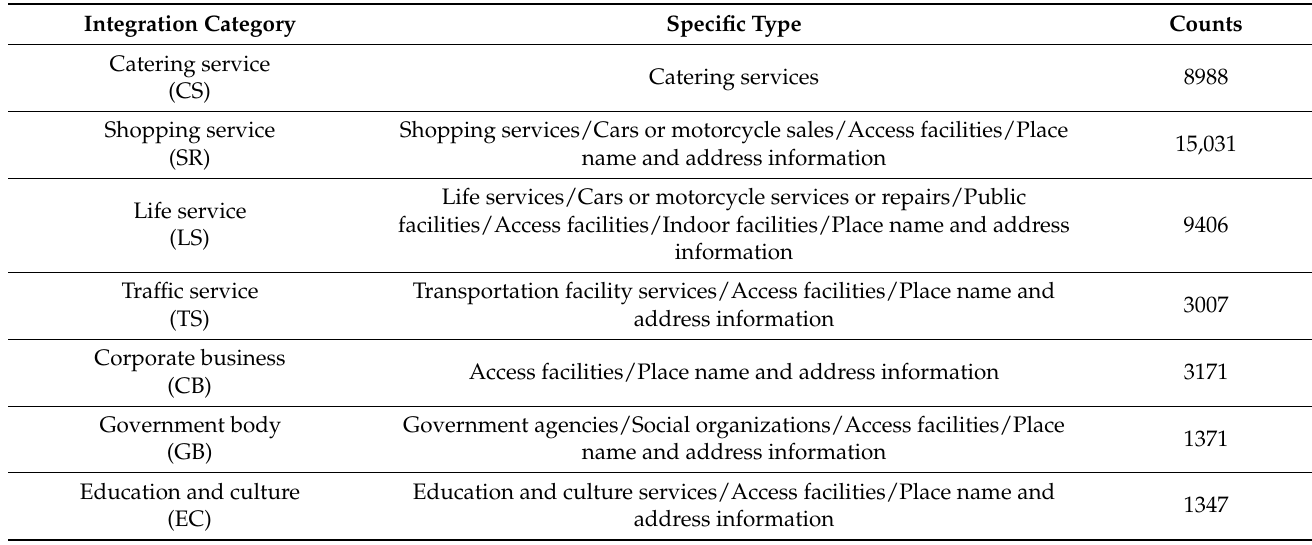
Table A1. POI data